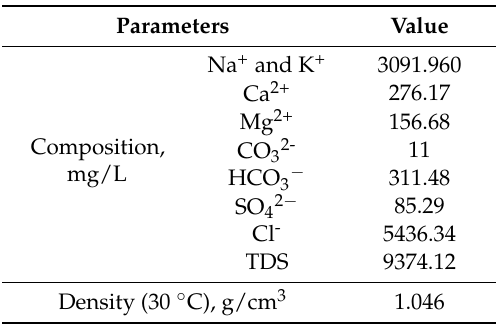
Table 3. The information of water used in this paper.